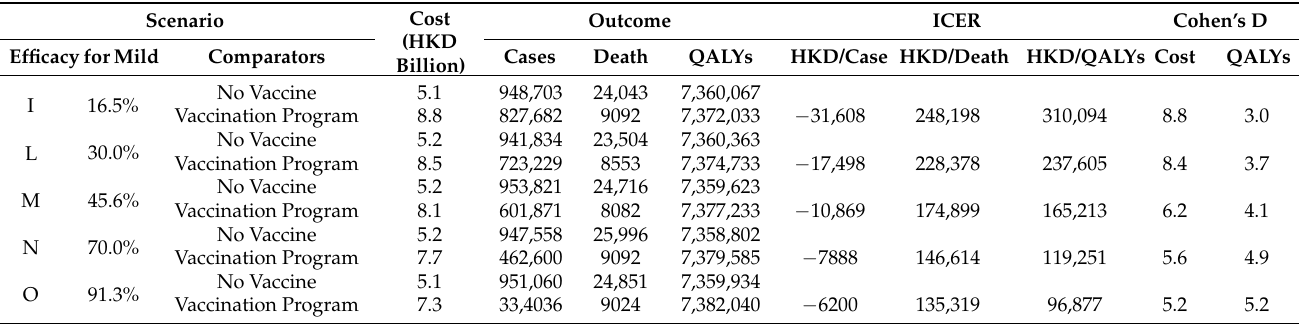
Table 4. Incremental cost-effectiveness ratio of the COVID-19 vaccination program adjusted for different levels of the protection rate under Omicron wave in Hong Kong.